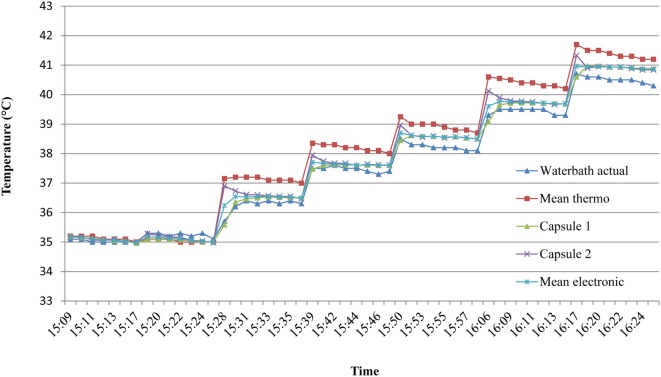
Time to reach temperature stability in ex vivo studies. To assess the time required for the capsules to equilibrate with water temperature, consecutive 60 s stepwise changes in temperature in the range 35–40°C were plotted over 8 min. A consistent change of less than 0.1°C from one reading to the next indicated thermal equilibrium, which was deemed to be by the fifth minute. Mean thermo = mean of two mercury thermometers. Mean electronic = mean of two identical electronic (EBRO) thermometers.